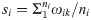
Mean scores, si, according to scientific category.We grouped 5363 respondents according to the Clarivate Analytics science category definitions [31] and then calculated a mean score per question for each category based on the total number of respondents per category, ni: si=Σ1niωik/ni.